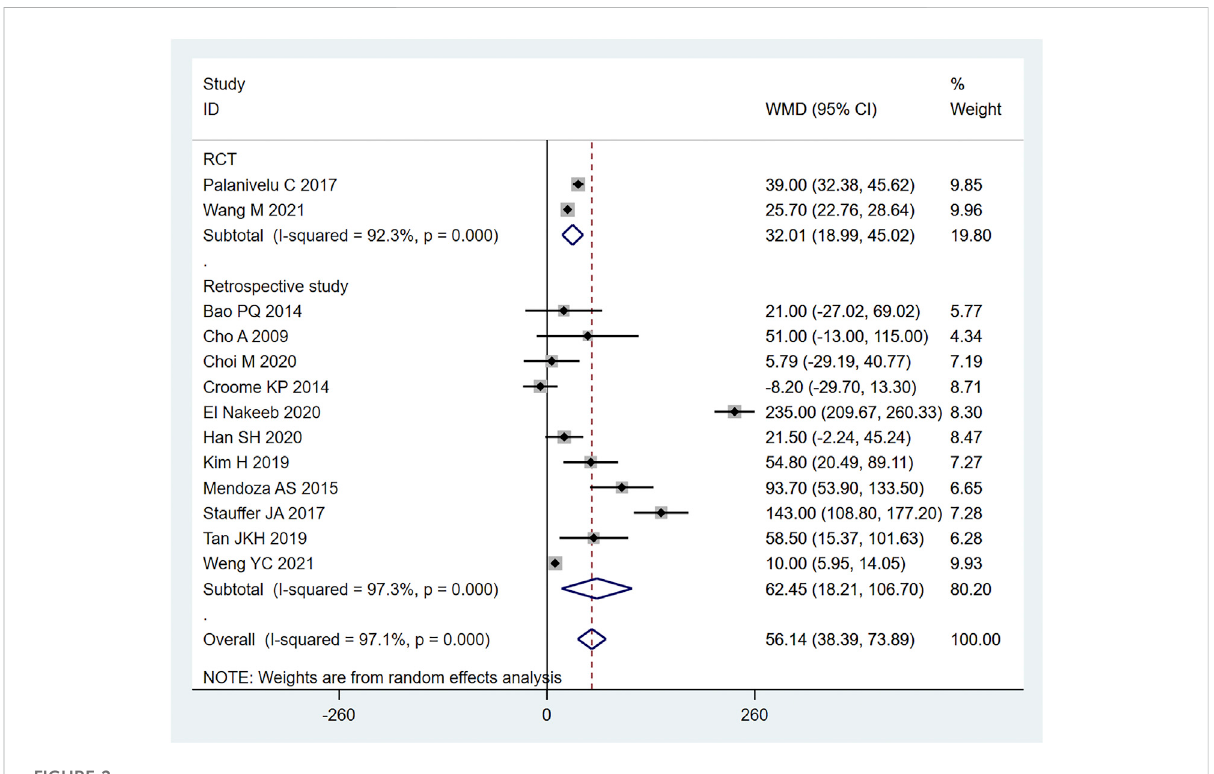
FIGURE 2 Forest plot of Meta-analysis of operation